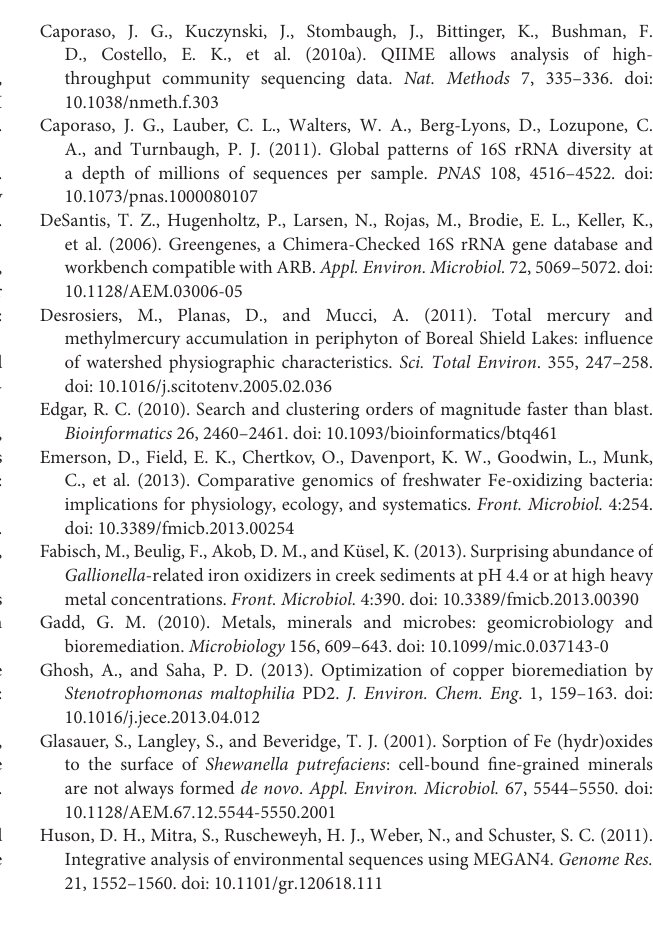
Table S1 | Number of metagenomic reads assigned to taxa for samples from Sites A and B. Table S2 | Number of metagenomic reads assigned to SEED functional groups for samples from Sites A and B. Table S3 | Number of reads per million assigned to genes associated with metal-resistance in the BacMet database. Figure S1 | Bar plots of microbial taxa profiles (class and order) in each replicate for each biofilm sampling site. Bar plots represent a summary of the taxonomic composition of each sample by (A) Class, and (B) Order, grouped by sampling Sites A–E ( n = 3 per site). Colors do not correspond between figures. Square brackets indicate proposed taxonomy based on Greengenes phylogenetic